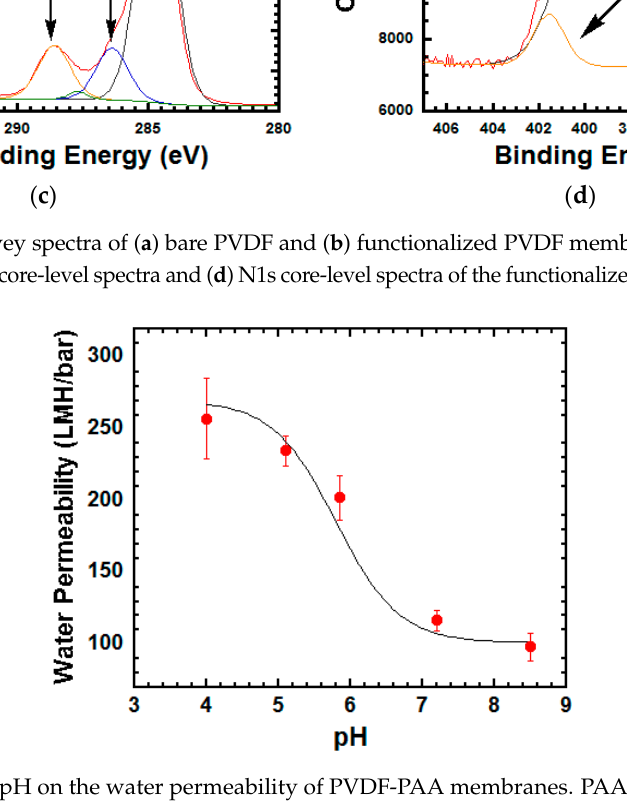
Figure 4. Effect of pH on the water permeability of PVDF-PAA membranes. PAA content = 10 wt %. PVDF-PAA membrane area = 13.2 cm 2 . T = 22 °C. Cross-linker ( N , N ′ -methylenebisacrylamide (MBA)) concentration of 1 mol% of monomer, acrylic acid (AA).